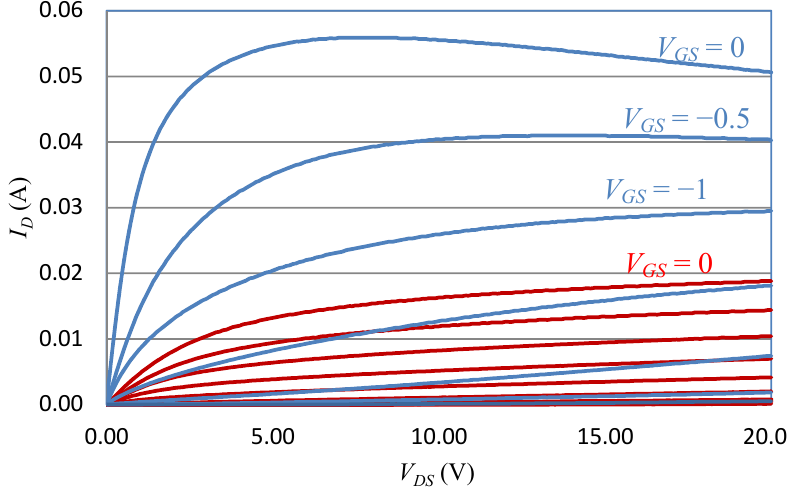
Figure 4. The on-state curves of the SiC vertical JFET at 25 °C (blue) and 525 °C